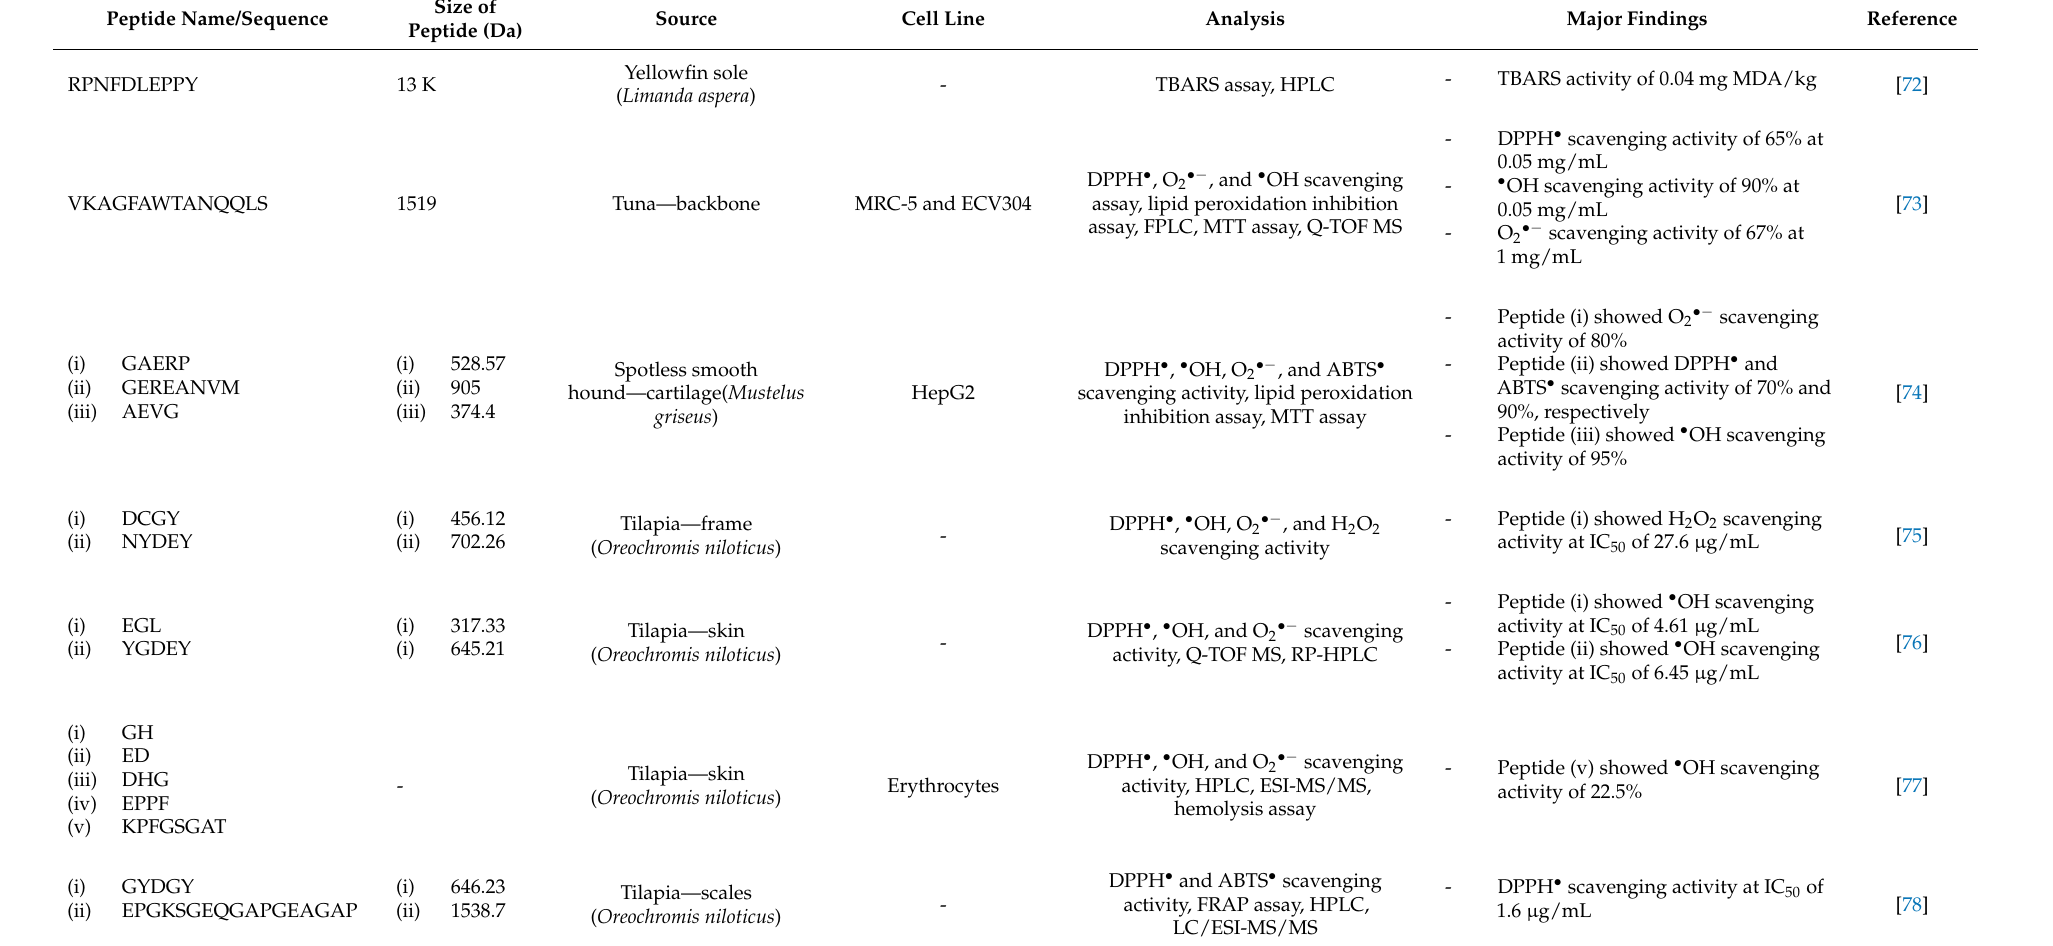
Table 1. Antioxidant effects of bioactive peptides from marine animals—in vitro